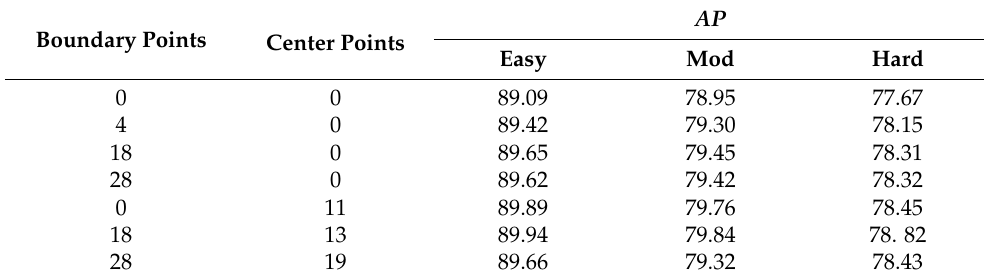
Table 6. AP of different keypoint settings.